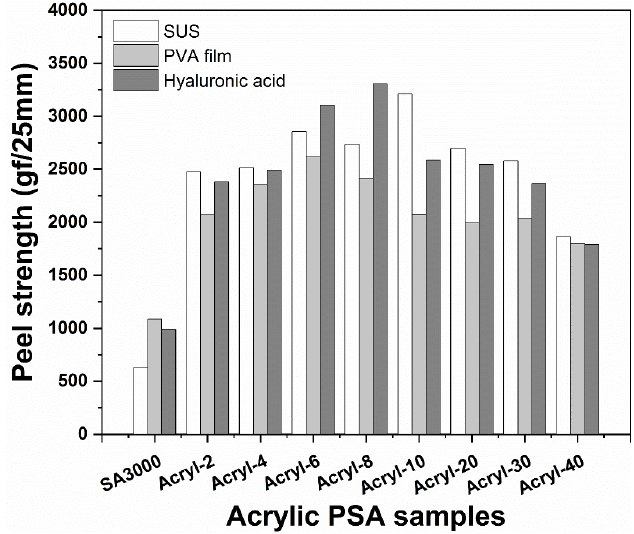
Figure 7. Evaluation of affinity of acrylic PSA films for hydrophilic materials: SUS, PVA film, and hyaluronic acid.